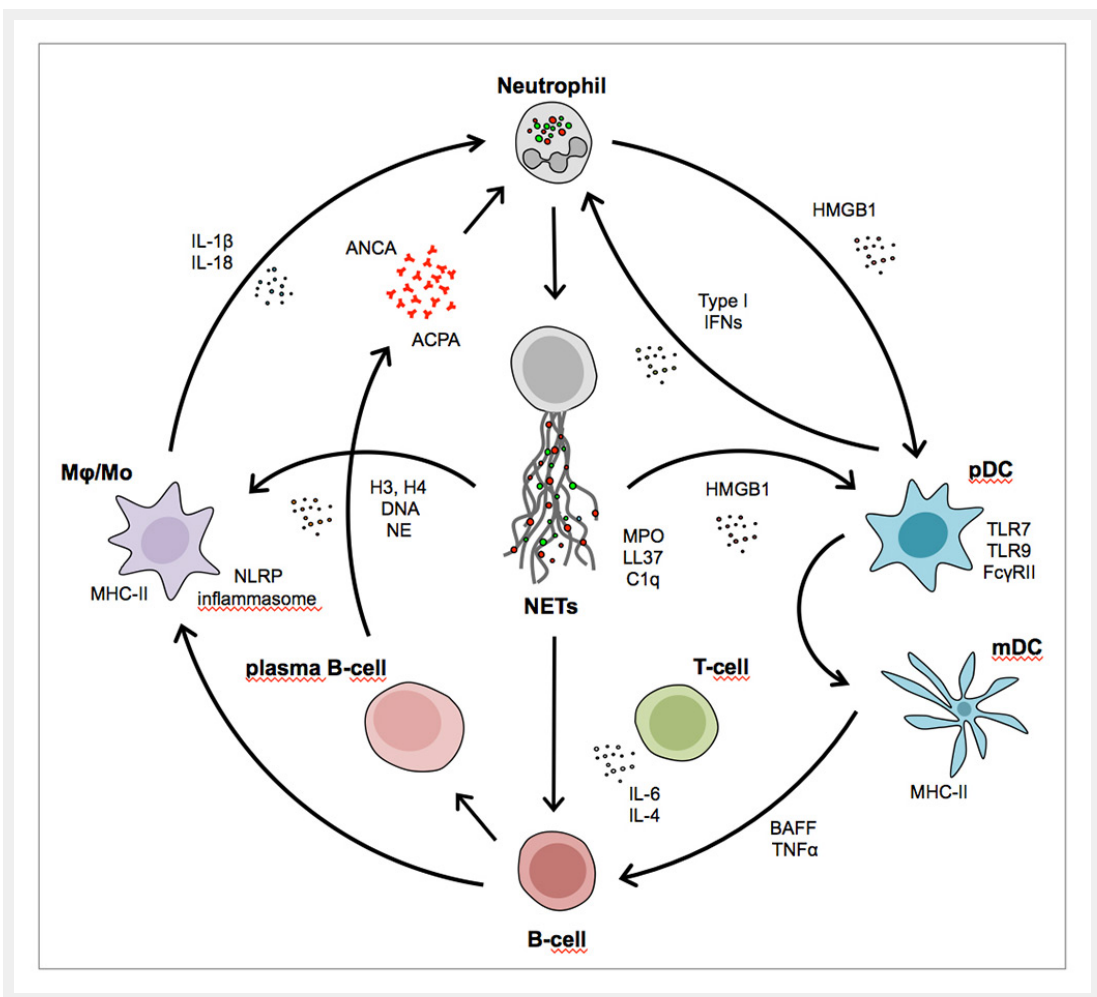
Figure 2 The interactions of pathways and innate and adaptive immune cell types connected with neutrophil extracellular trap formation. ACPA = anti-citrullinated peptide antibody; ANCA = anti-neutrophil cytoplasmic antibody; BAFF = B cell activating factor; FcγRII = Fc gamma receptor II; H3, H4 = histones; HGMB1 = high mobility group box 1 protein; IFN = interferon; IL = interleukin; LL37 = cathelicidin; mDC = myeloid dendritic cell; MHC = major histocompatibility complex; Mϕ/Mo = monocyte subtypes; NE = neutrophil elastase; NET = neutrophil extracellular trap; pDC = plasmacytoid dendritic cells; TLR = Toll-like receptor; TNFα = tumour necrosis factor